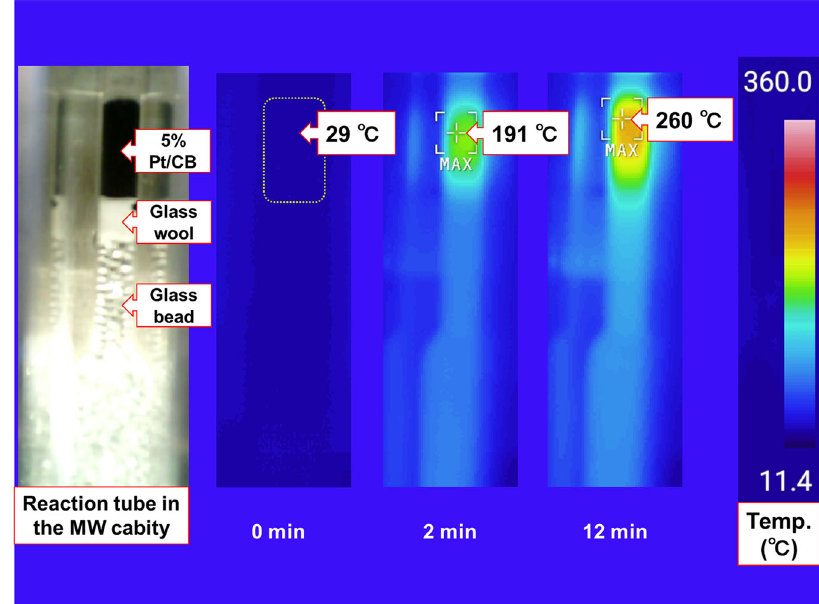
Fig. 2 Selective MW-absorption effect on Pt/CB. Temperature transition of 5% Pt/CB under 10 W single mode-MW irradiation after 0, 2, and 12